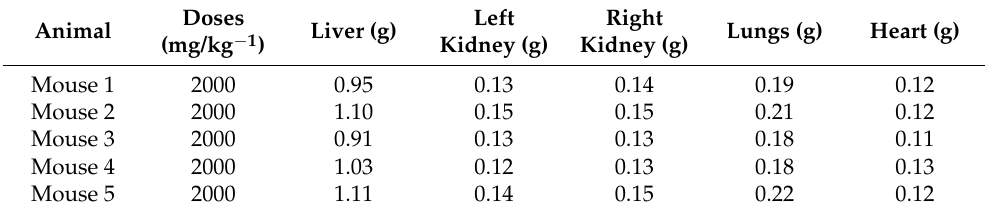
Table 4. Weight of the organs of the animals orally exposed to the AgNPs. Animal